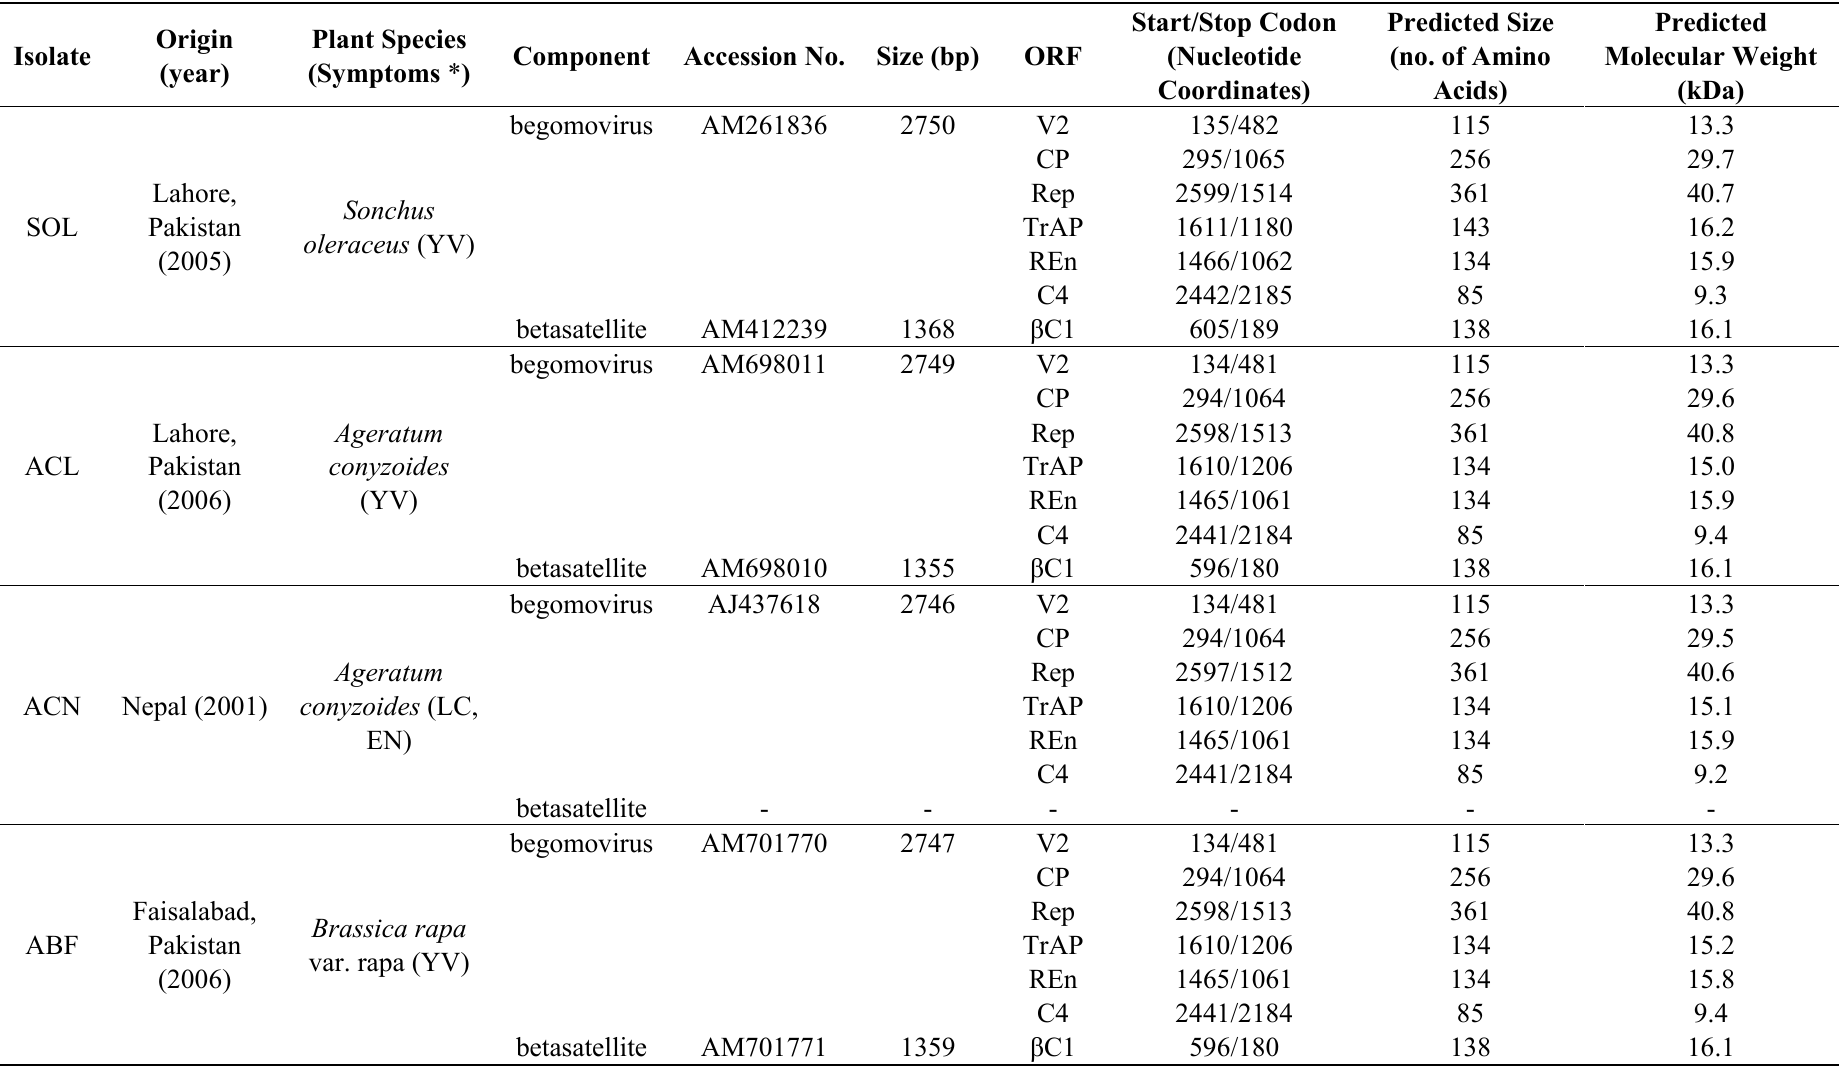
Table 1. Origins of the virus isolates and features of the begomovirus and betasatellite clones obtained.